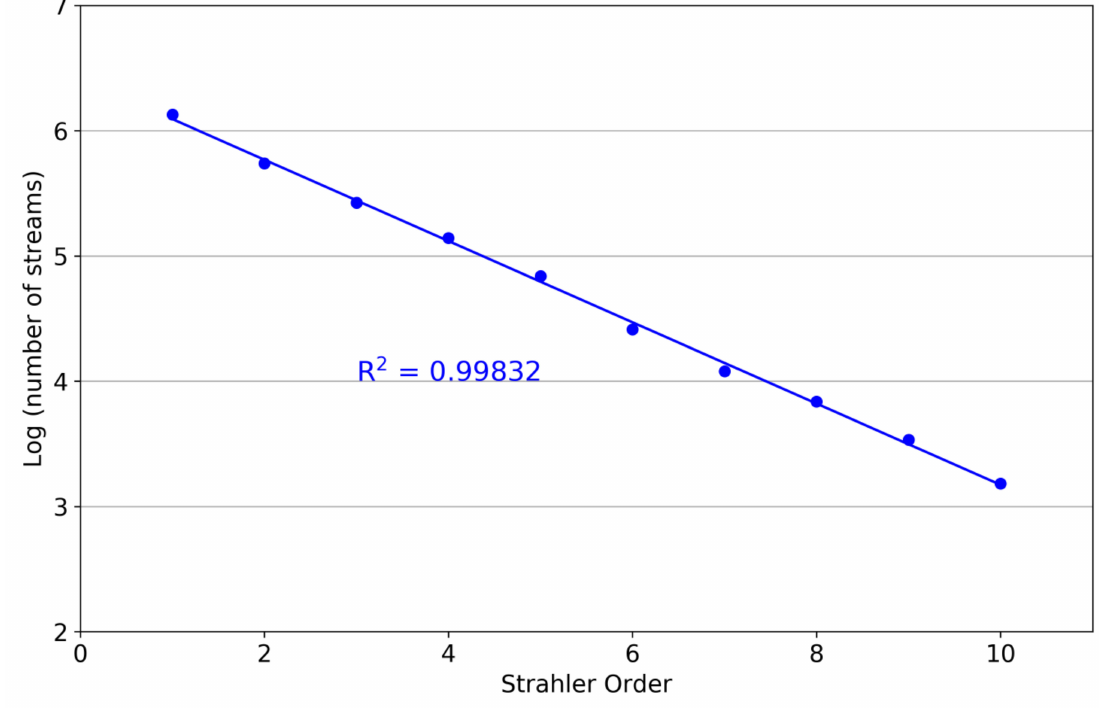
Figure 16. Number of streams according to Strahler order.